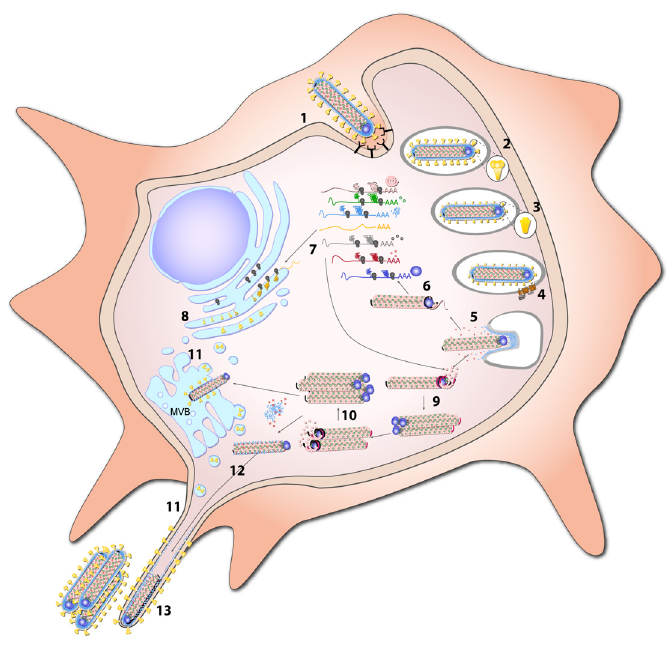
is cleaved by endosomal proteases 1